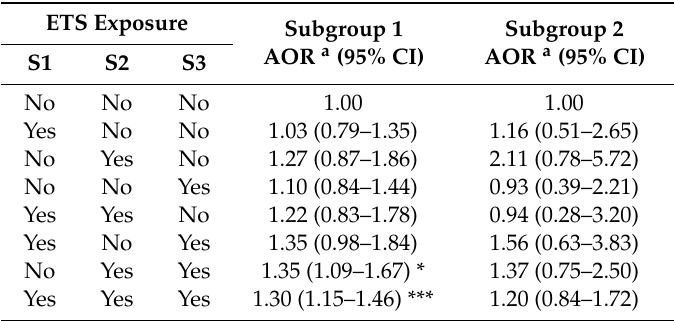
Table 5. Sensitivity analysis of association between astigmatism and combinations of pre- and post-natal ETS exposure among children with a full-term pregnancy and premature infant.